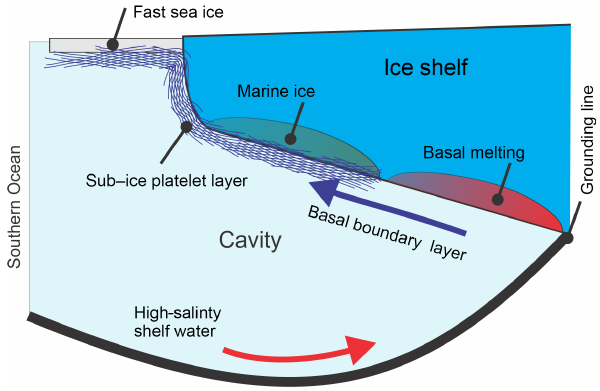
Figure 1. Ice pump showing High-Salinity Shelf Water (HSSW) flowing in at the base of an ice shelf cavity, commencing basal melt- ing at, or around, the grounding line. This buoyant meltwater flows upwards and outwards in a basal boundary layer. An associated sub- ice platelet layer supports ice growth through freezing into marine ice and sub-ice platelet layer beneath fast sea